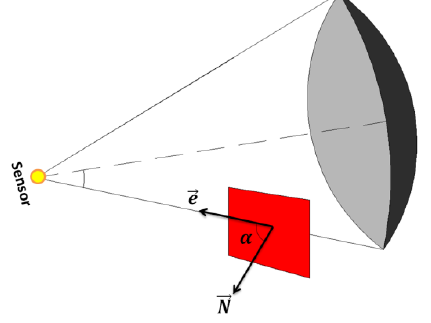
Figure 4. Elimination of the back-face polygons through the   sign of the vector N e . Figure 6. Elimination of the polygon A lies outside of the sensor distance range. The portion of the polygon C that lies outside of the distance range is